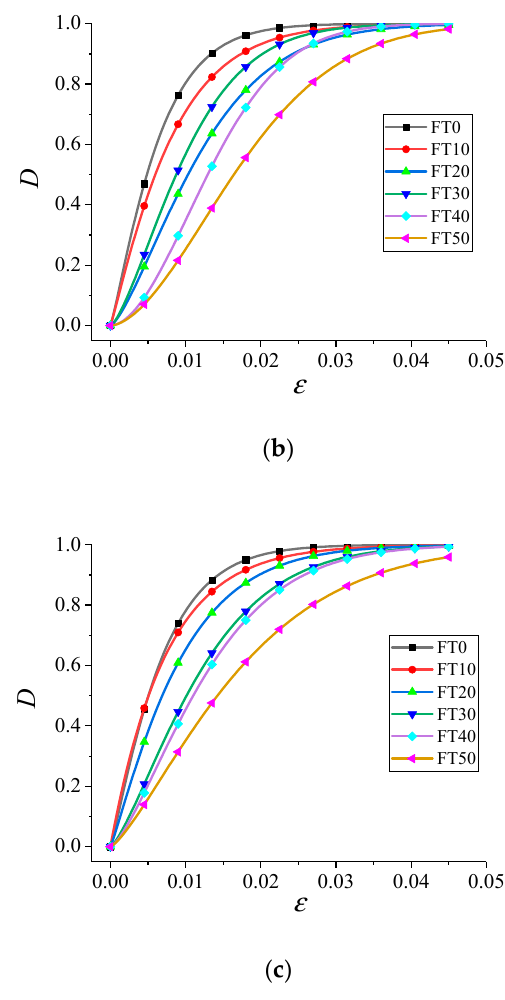
Figure 14. Damage evolution curve of freeze–thawed concrete. ( a ) 5.4 m/s; ( b ) 8.8 m/s; ( c ) 11.3 m/s.